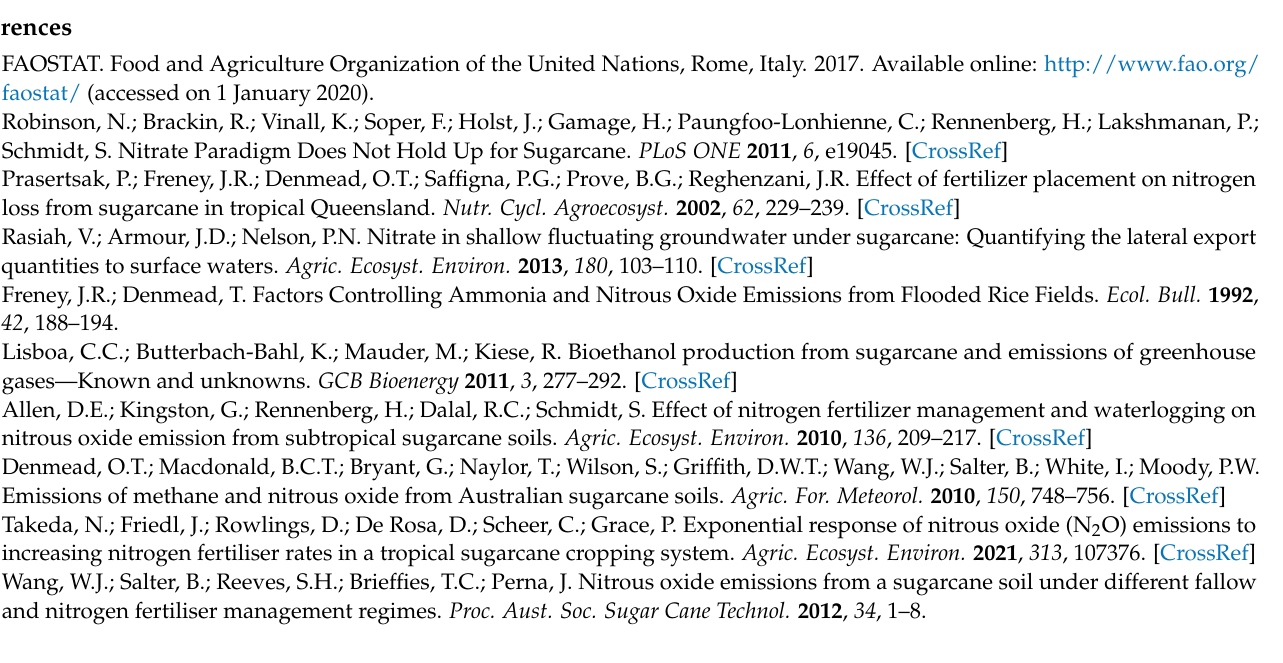
Table S2: Physical and chemical properties of the poultry litter and amendments used in the field trial. Data are means of 3 replicates ± SD; <d.l. below detection